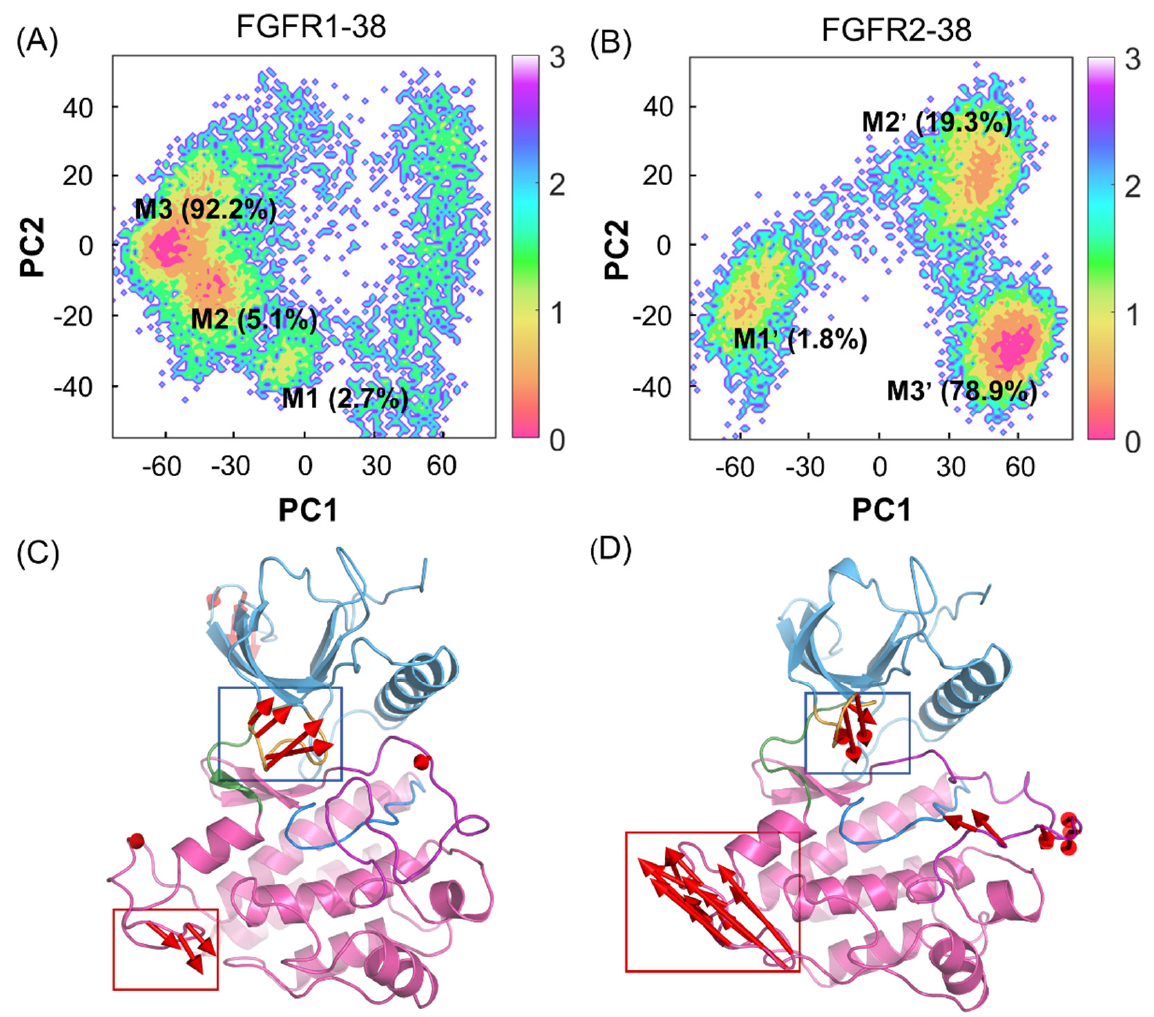
Figure 4. PCA of FGFR1-38 and FGFR2-38 systems. The free energy landscapes of the first and second principal components (PC1 and PC2) for the FGFR1-38 ( A ) and FGFR2-38 ( B ) systems. The unit of free-energy values is kcal/mol. The porcupine plots of the FGFR1-38 ( C ) and FGFR2-38 ( D ) systems depict the principal pattern of motion along PC1. The N-lobe (blue) and C-lobe (pink), P-loop (orange), catalytic loop (marine), A-loop (purple), and hinge region (green) are highlighted. The sizes and lengths of the red arrows are proportional to the amplitude of motions.